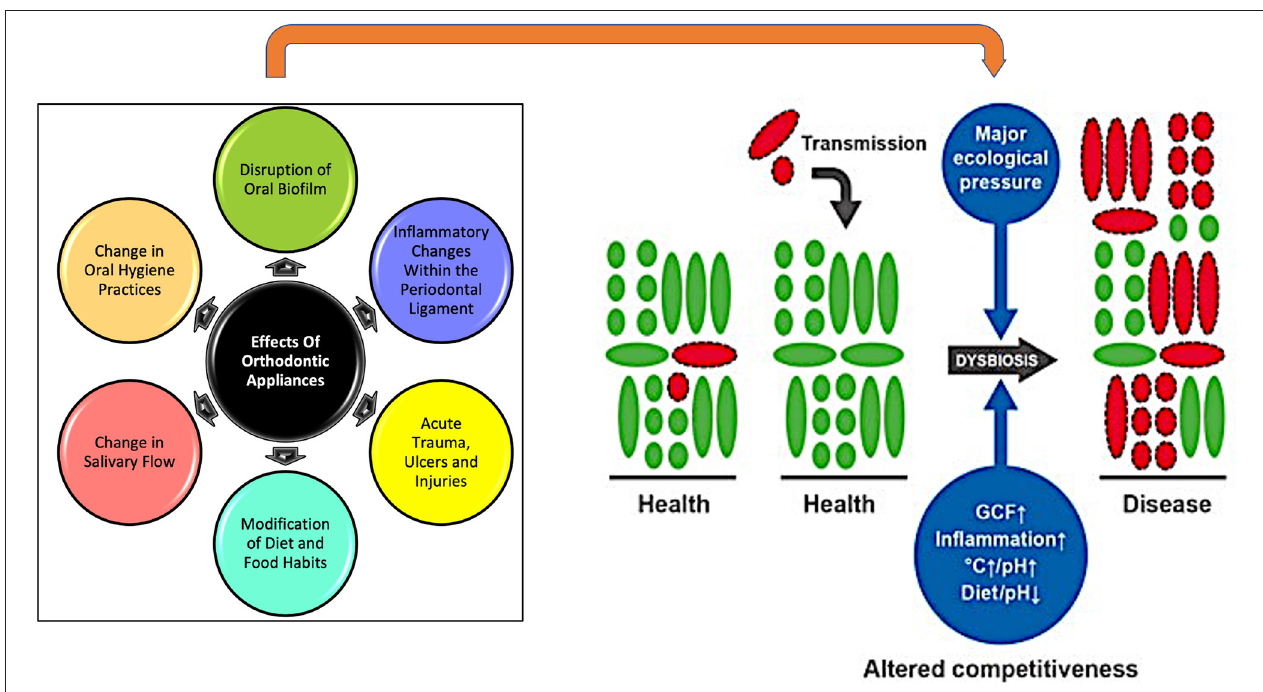
FIGURE 2 | The intra-oral effects of having an orthodontic appliance in place, act as significant disruptors. They exert major ecological pressure causing dysbiosis and shift in oral microbiome from predominantly healthy microbiota (green) to predominantly pathogenic bacteria (red). [Adapted from Kilian et al. ( 4)].